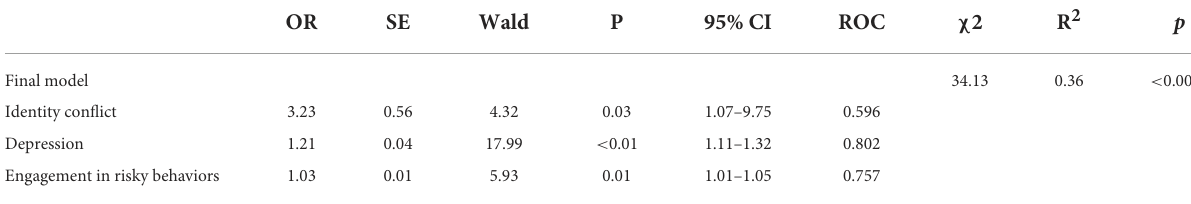
TABLE 4 Logistic regression results for the relationships among identity conflict, depression, and engagement in risky behaviors in regard to non-suicidal self-injury.